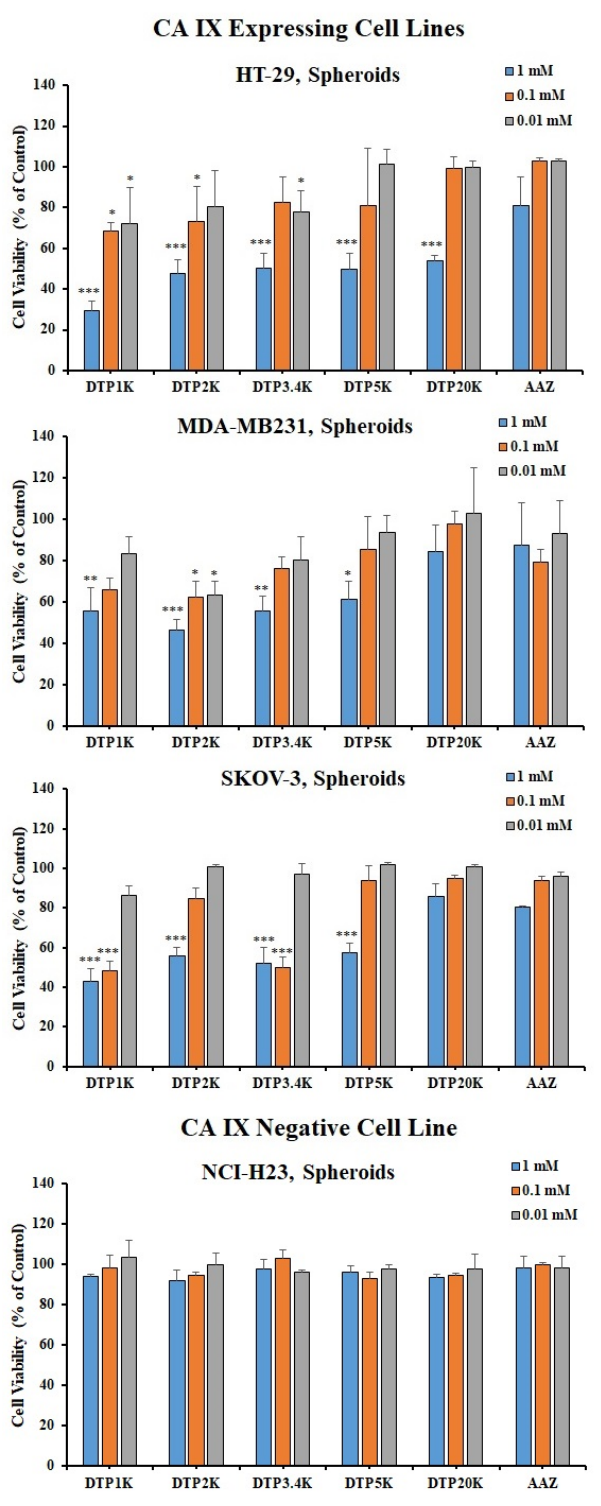
Figure 4. Effect of PEGylated CAIs DTP2K 23 and DTP1K 28 – DTP20K 31 and acetazolamide AAZ 1 at three different concentrations on the viability of CA IX expressing HT-29, MDA-MB231, and SKOV-3 and of CA IX-negative NCI-H23 3D cell cultures (all 3D tumor spheroids): the p values were determined by one-way ANOVA, comparing the value with that of acetazolamide 1 (* p < 0.05, ** p < 0.01, and *** p < 0.001). Only the statistically significant differences are shown.